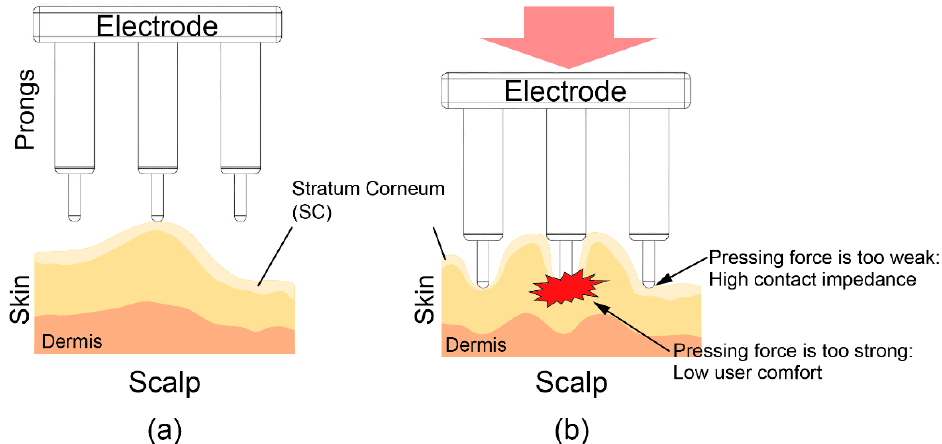
Figure 1. Illustration of a dry electrode and scalp. ( a ) Prongs of the dry electrode are pressed onto the scalp. ( b ) The pressing force is concentrated on a few prongs due to the uneven surface of the scalp.